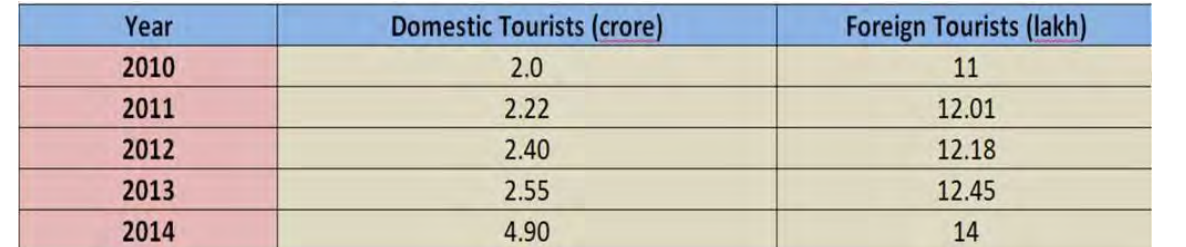
Table 3: Year-wise growth of tourist footfall in